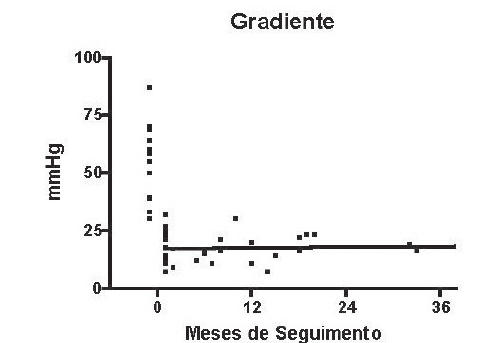
Fig. 1 - Gradientes pré e pós-operatórios de acordo com a técnica operatória empregada. T/T = término terminal; PB = pericárdio bovino